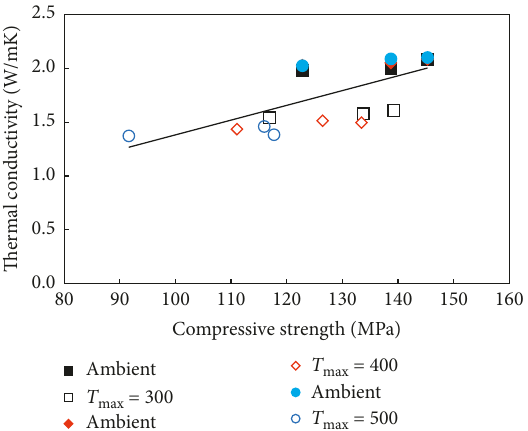
Figure 14: Relationship between the thermal conductivity and compressive strength of the UHPC at different maximum